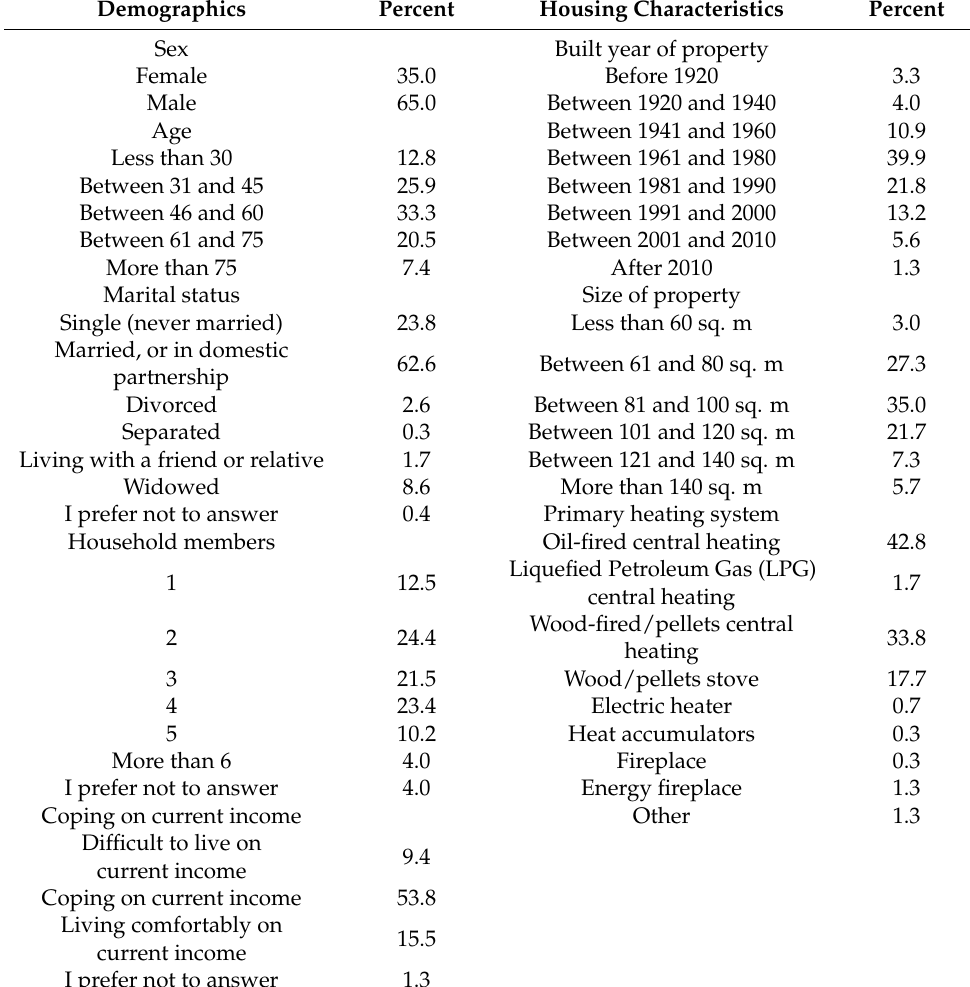
Table 2. Population and housing